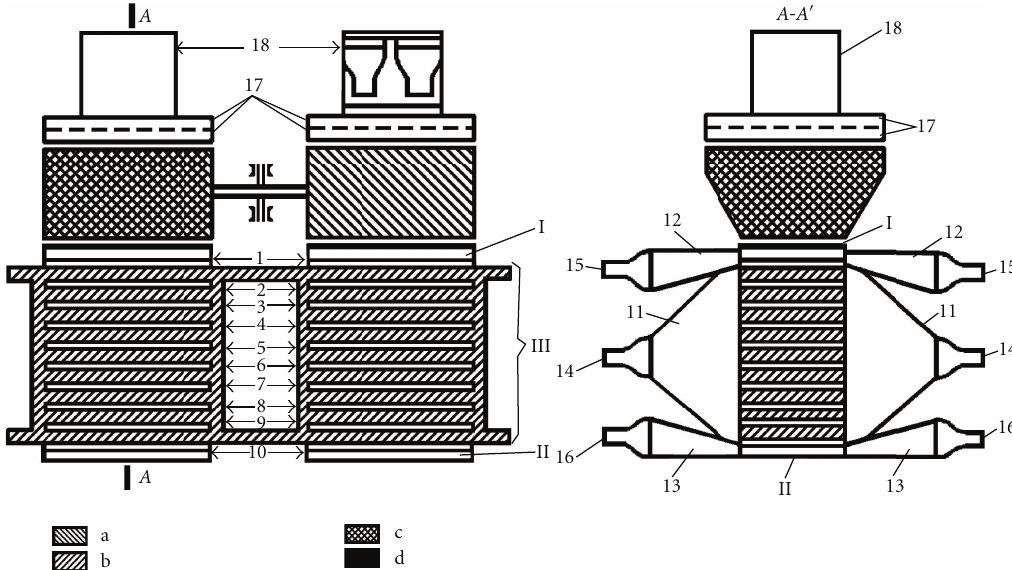
Figure 6: Schematic view of the device SEZ-14. I: detector of interactions; II: lower scintillation detector; III: ionization calorimeter; 1– 10: scintillators of the detector of energy; 11: diffuser of the detector of energy; 12: diffuser of detector of interactions; 13: diffuser of lower scintillation detector; 14–16: photomultipliers; 17: charge detector (doubled proportional counter); 18: detector of the direction; a: absorber; b: iron; c: carbon; d: